Question: What type of chart is this?
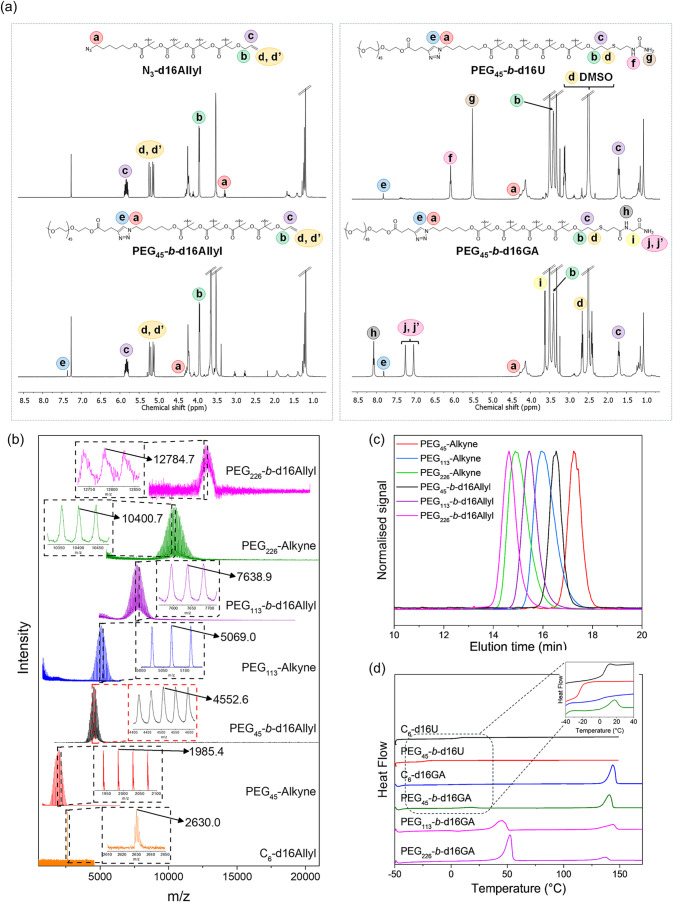
Answer: line